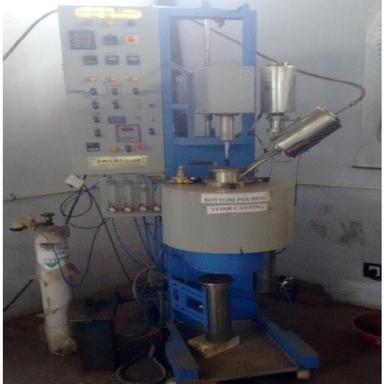
Bottom Pouring Stir Casting Machine, at the Advanced Welding and Casting Lab, PEC University, Chandigarh